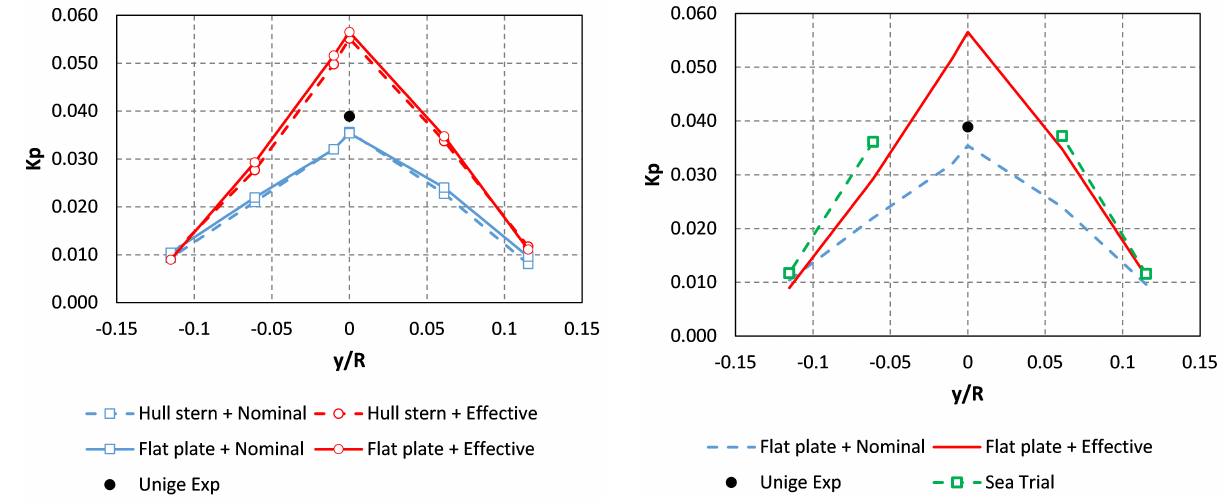
Figure 16: Comparison between predicted and measured pressure pulses (first harmonic) in cavitating condition on the transversal section in correspondence of the propeller